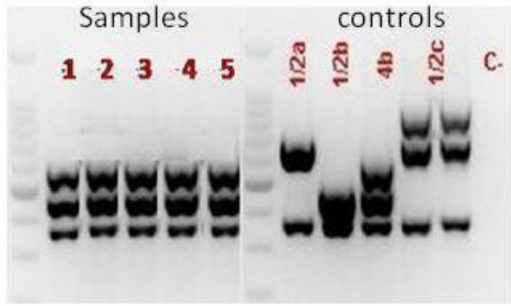
Figure 2. PCR-based serotyping of L. monocytogenes strains isolated from food, environmental surfaces, and biological specimens.